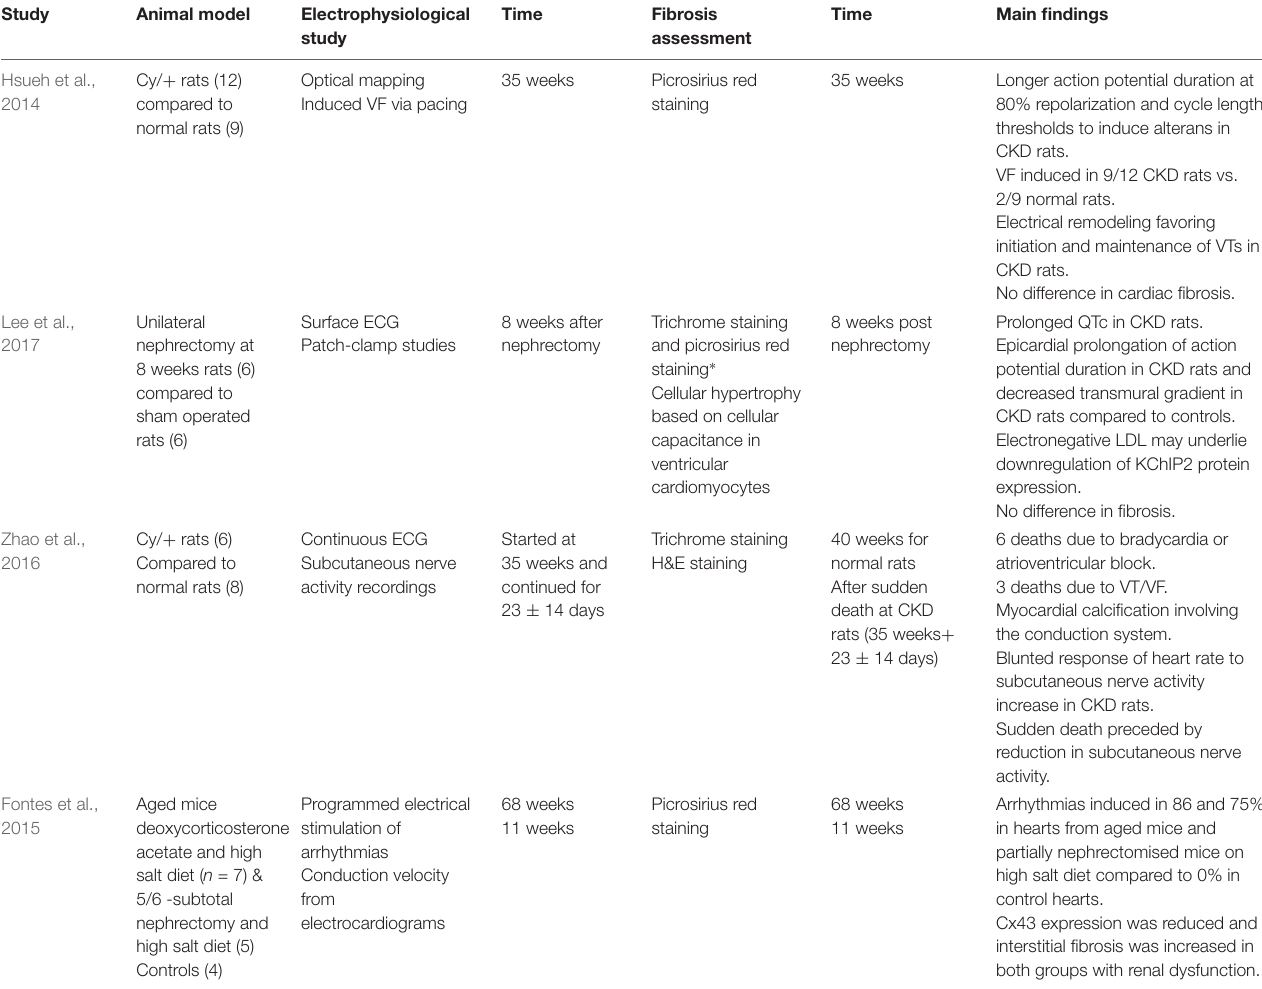
TABLE 2 | Electrophysiological studies in animal models of